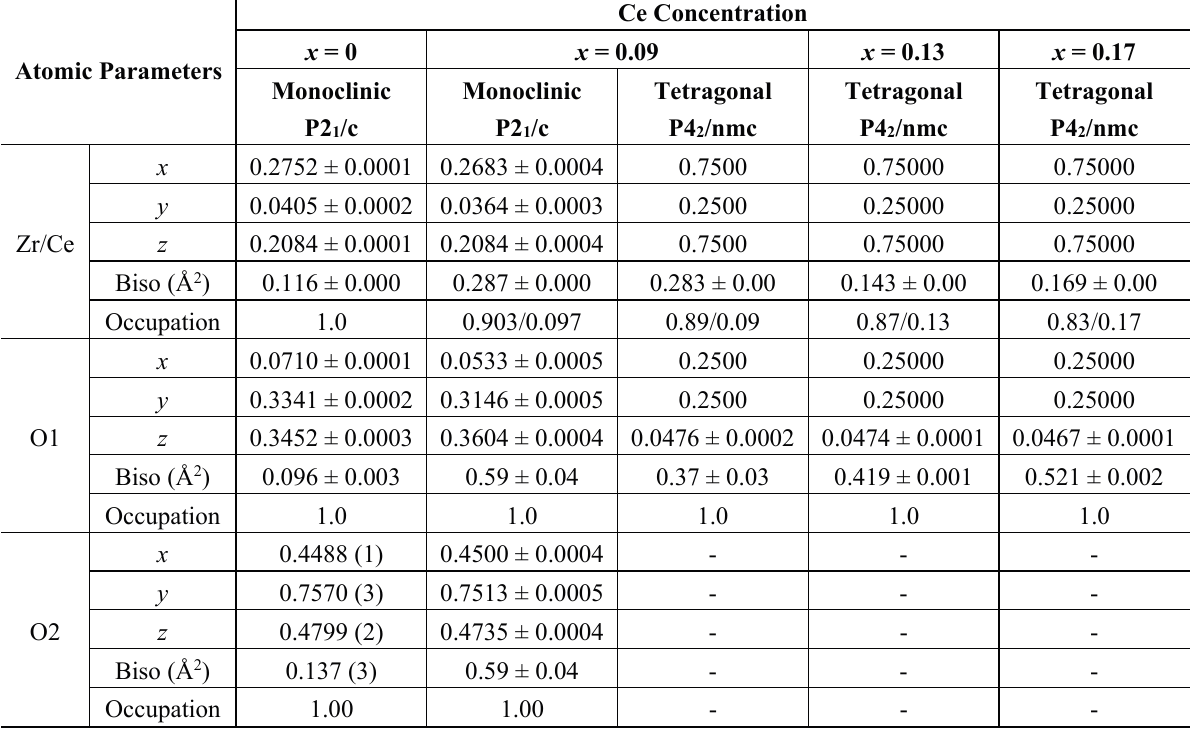
Table 2. Atomic positions and isotropic thermal parameters of Zr 1- x Ce x O 2 ( x = 0–0.17) calculated using the Rietveld method from neutron diffraction data. P2 1 /c: Zr (4e) ( xyz ); O1 (4e) ( x , y , z );